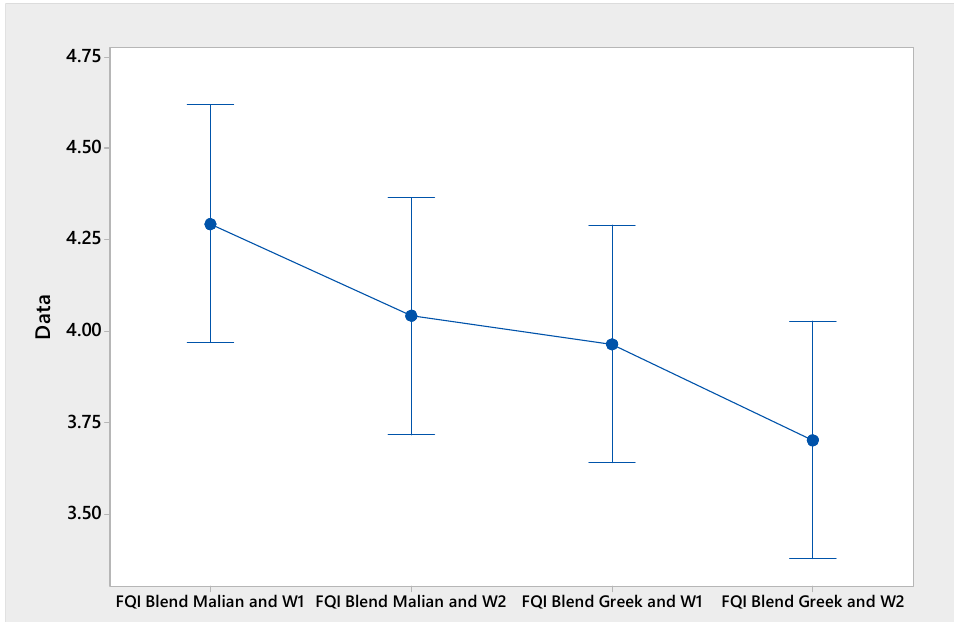
Figure 1. Variation in FQI for different blends.